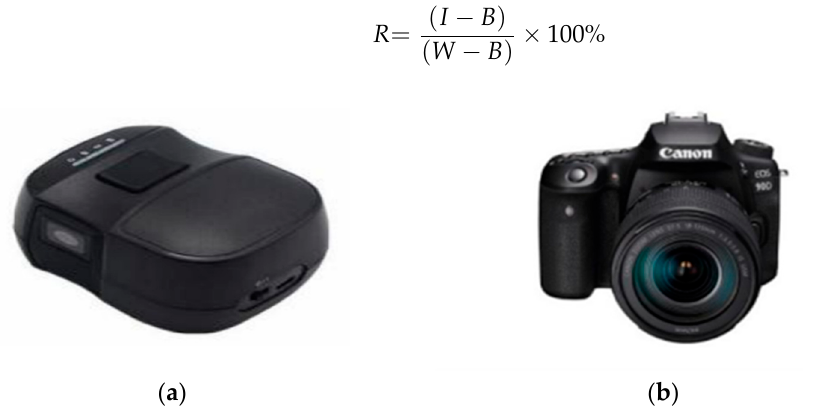
Figure 2. Instruments utilized for spectral data acquisition in the experiment: ( a ) “NIR-S-G1” miniature spectral acquisition apparatus; ( b ) “EOS 90D” single-lens reflex digital camera.